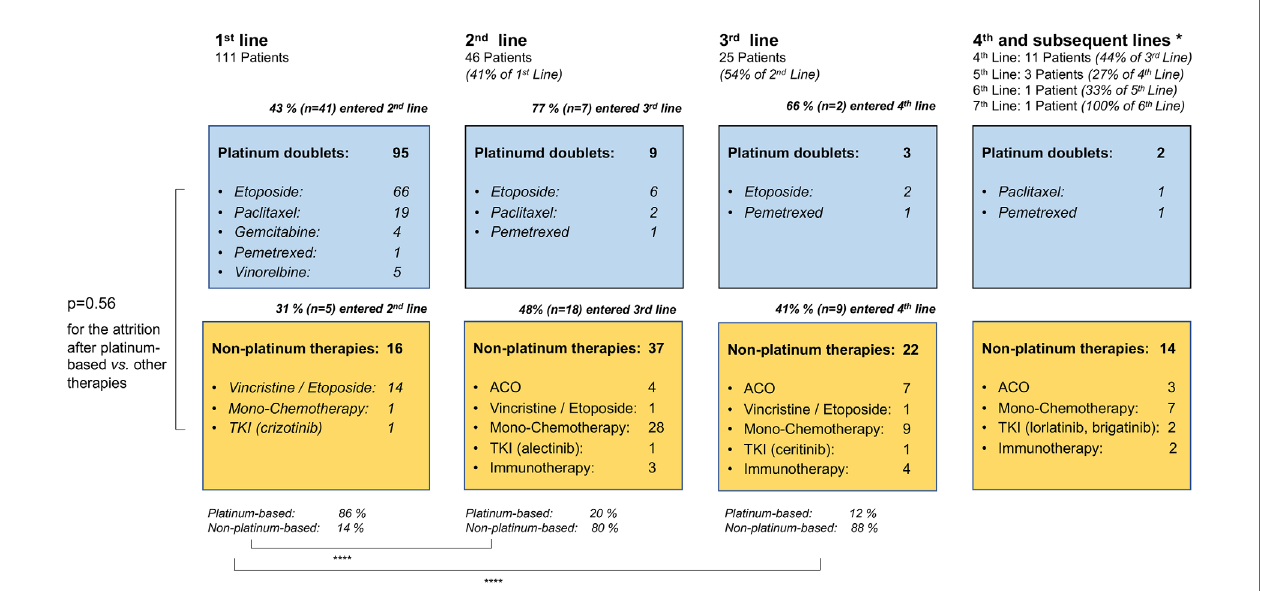
FIGURE 5 | Flow of patients with metastatic LCNEC across treatment lines. This analysis was performed in the subset of patients who received palliative systemic treatment and have complete follow-up available until death ( Figure 1 ). ACO, adriamycin, cyclophosphamide, vincristine; TKI, tyrosine kinase inhibitors; immunotherapy: immune checkpoint inhibitors. The ALK-positive LCNEC patient has been published previously (26). * 4th and subsequent lines cumulated; ****p < 0.0001 with a chi-square test for the percentage of platinum-based vs. non-platinum-based therapies in the fi rst vs. second and third line; p = 0.56 with a mixed linear model for the attrition rate after platinum-based vs. other chemotherapies across the fi rst three treatment lines.